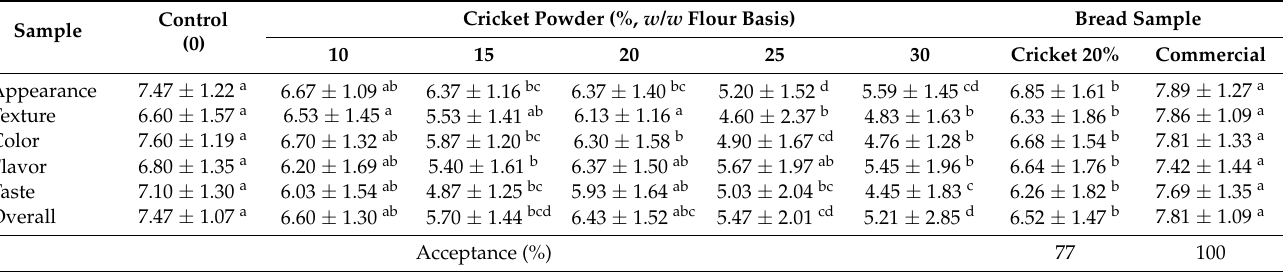
Table 4. The sensory evaluation from 30 and then 100 panelists consumed the control and whole wheat bread enriched with cricket